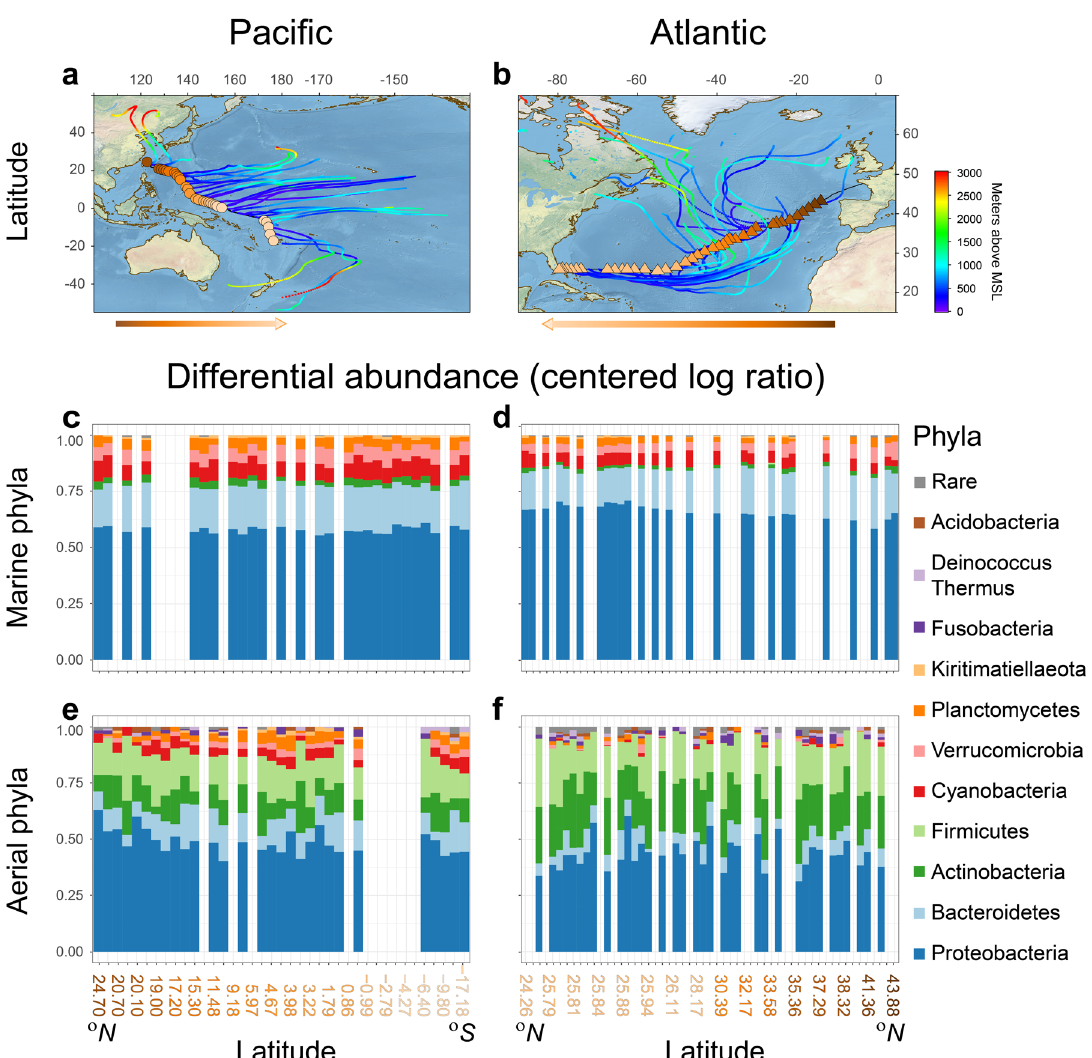
Fig. 1 Regional distribution of airborne bacterial phyla above the Paci fi c and Atlantic oceans. Air-sampling locations and back trajectories, with height above mean sea levels (MSL) indicated with color scale for the Paci fi c ( a ) and Atlantic ( b ) atmospheric samples. Phyla differential abundance (centered log-ratio; CLR- converted abundance) in the water ( c , d ) and the air ( e , f ) for taxa observed in >5% of the samples in the Atlantic and Paci fi c transects,